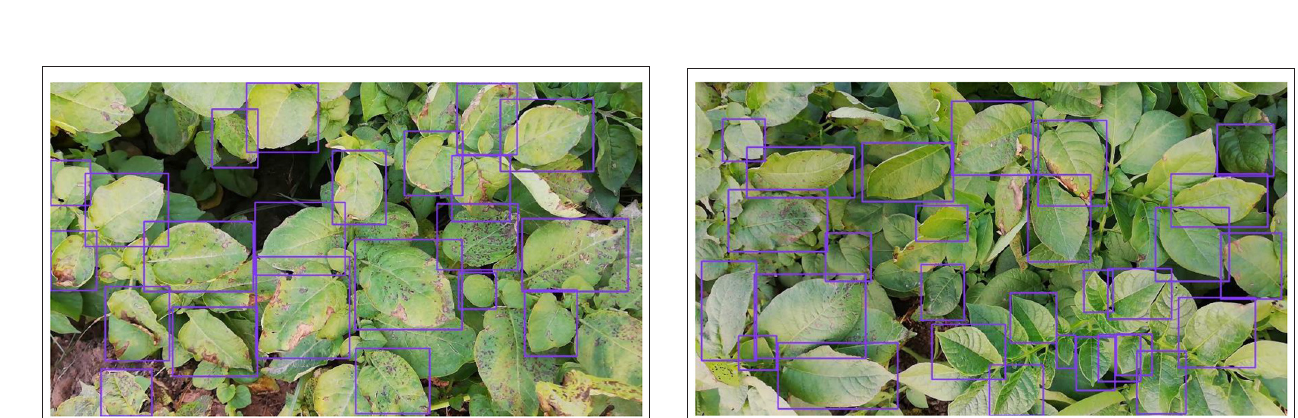
FIGURE A1 | Confusion matrix for the predictions of the best model trained on the PFD dataset.